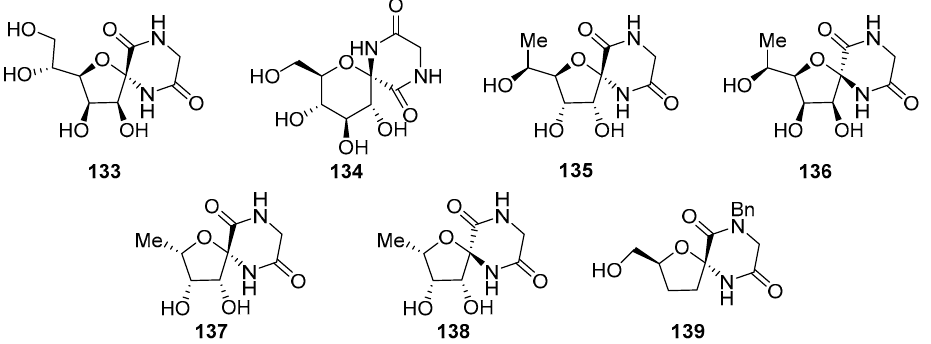
Figure 8. Analogues of hydantocidin containing a diketipiperazine ring.